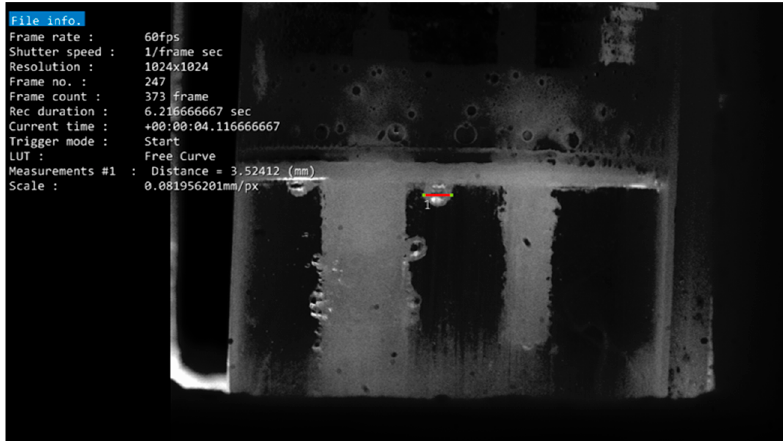
Figure A2. An example of measurement of the bubble diameter during electrolysis using the vertical anode at current density 0.25 A cm − 2 .